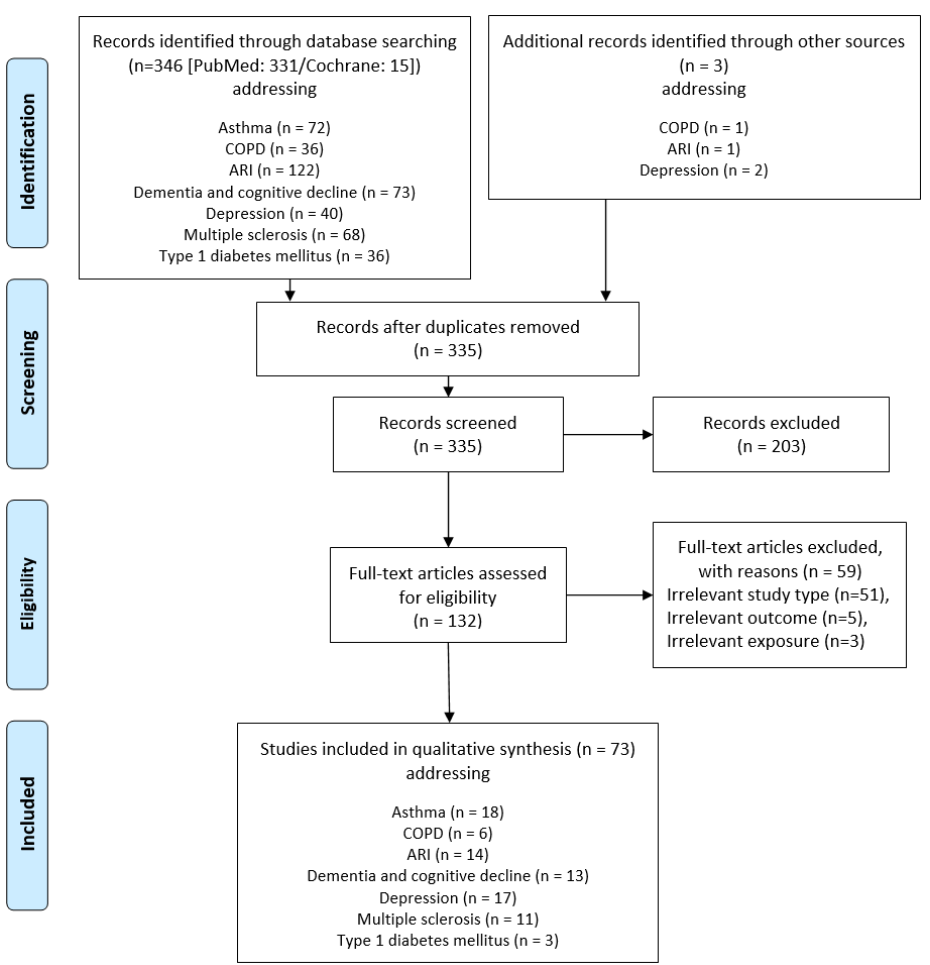
Figure 1. PRISMA flow diagram—all outcomes.